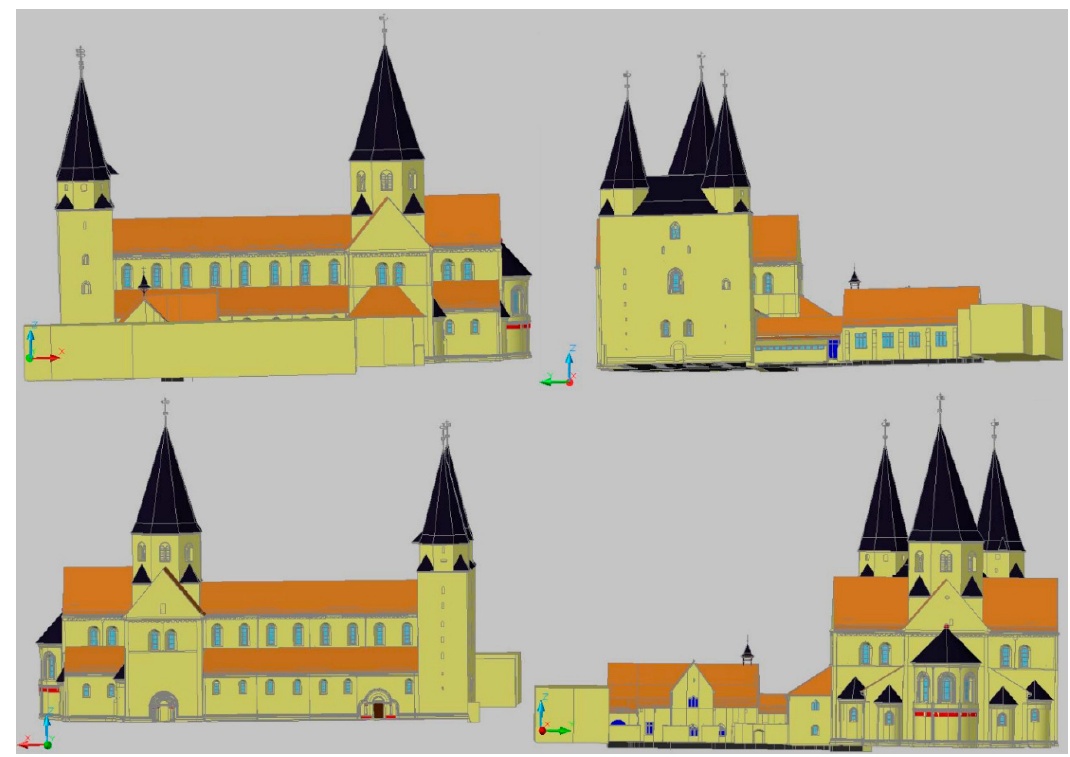
Figure 4. Constructed 3D model of the imperial cathedral in Königslutter, Germany—View of the four fronts in AutoCAD.